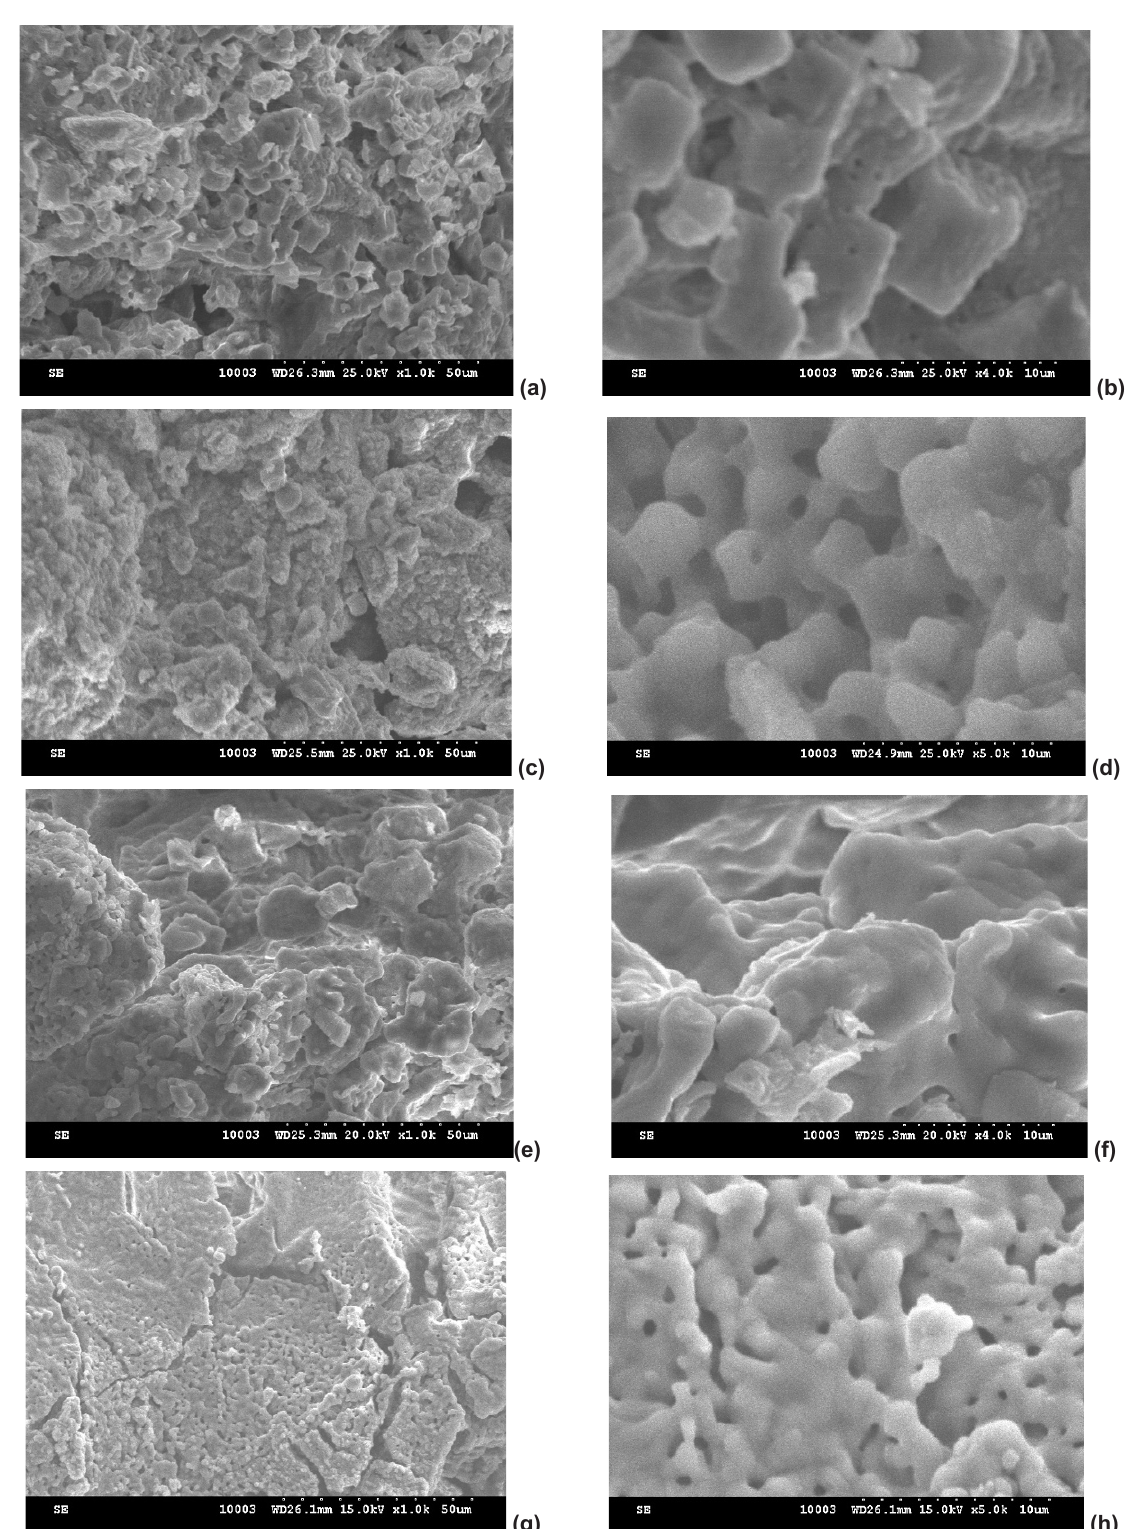
Figure 6. SEM micrographs of: K - a and b; KZ – c and d; KZF - e and f; KF – g and